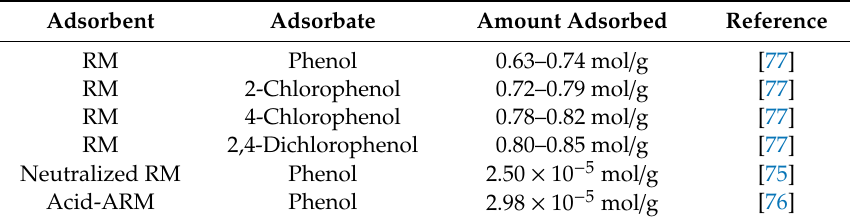
Table 4. Adsorption capacity of RM for the removal of phenolic pollutants from water [37,75–77]. Reproduced with permission from [37], published by Taylor & Francis,